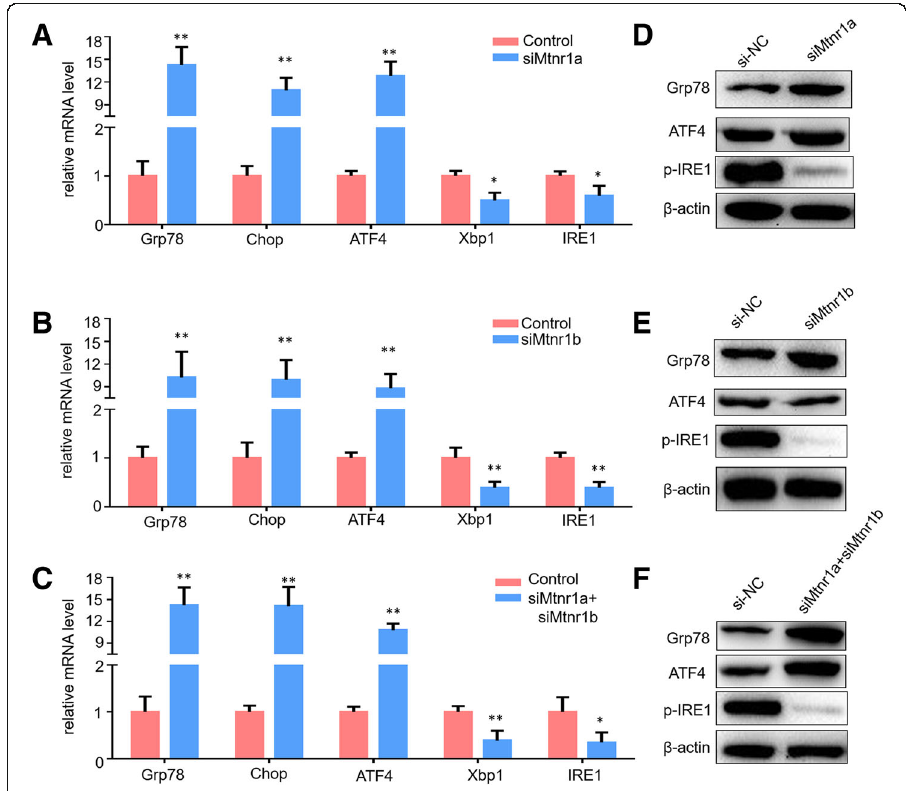
Fig. 5 Effects of MTNR1A and MTNR1B knockdown on endoplasmic reticulum stress. a - c . Relative mRNA expression of endoplasmic reticulum (ER) stress genes, Grp78, Chop, ATF4, Xbp1 and IRE1, was evaluated using qPCR assay after treatment with the siRNAs against MTNR1A and MTNR1B for 48 h in mLTC-1. The mRNA levels were normalized to that of Gapdh. Data are presented as the mean ± SEM of three triplicates. * P < 0.05, ** P < 0.01 (Student ’ s t-test). d - f . Western blotting analyses of Grp78, ATF4 and phospho-IRE1 expression in mLTC-1 after knockdown of MTNR1A and MTNR1B using specific